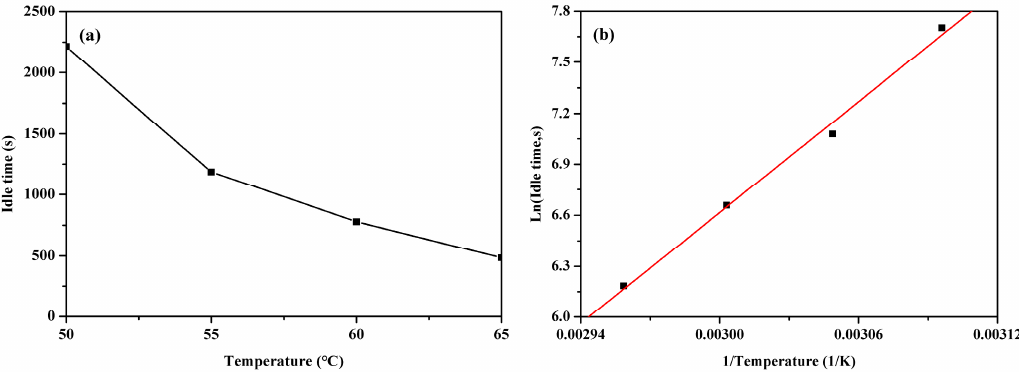
Figure 7. Idle time ( a ) and Arrhenius plot ( b ) for 42.0 vol.% KNN suspensions obtained from Figure 6.